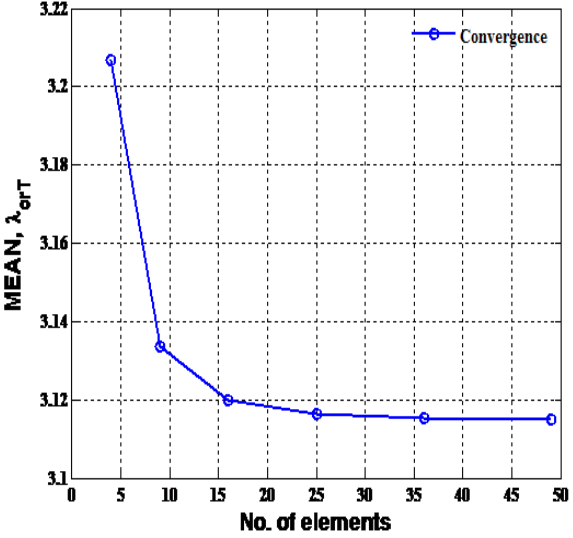
Figure 2: Convergence study for mean buckling temperature of a square laminated composite plate.